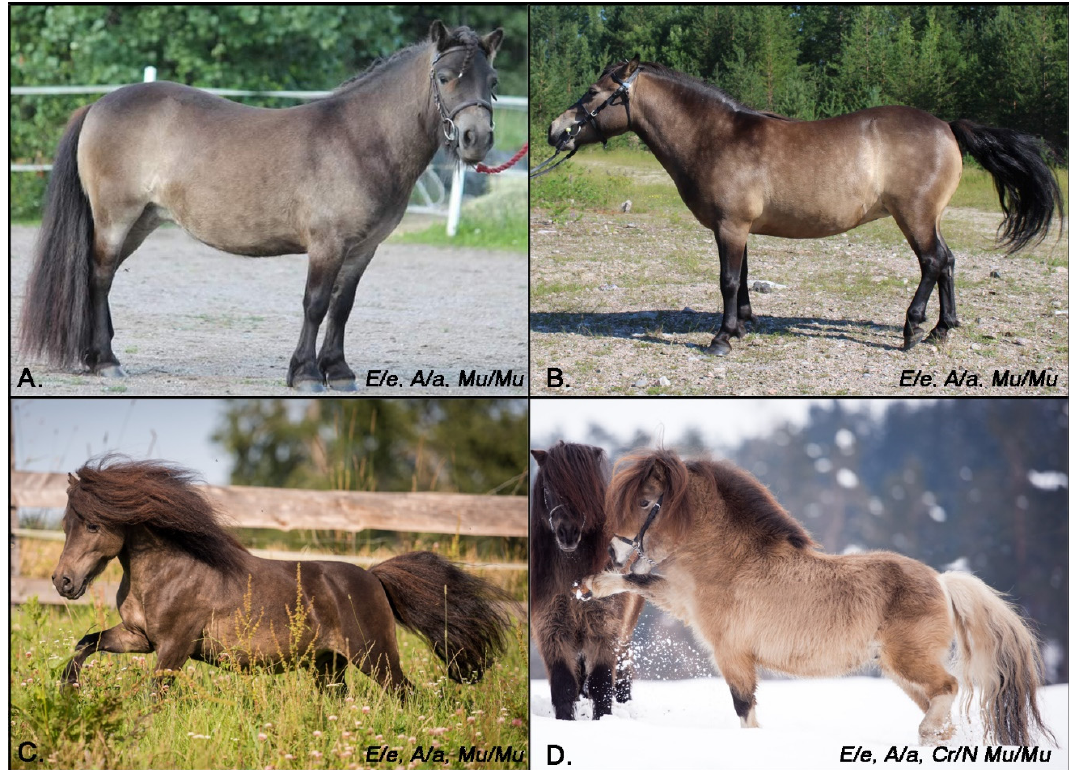
Figure 3. Bay mushroom Shetland Ponies. ( A ), ( B ), ( C ) Three bay ponies homozygous for the mushroom variant showing a coat lacking the red hue as typically seen in bay horses without the mushroom dilution. These bay mushroom ponies have normally pigmented mane and tail with countershading on the shoulders neck and head of these ponies. ( D ) Buckskin homozygous for the mushroom variant. The countershading is consistent with other “bay mushroom” ponies though the combination of mushroom and cream is likely contributing to the lighter shade in the coat of this pony as compared to the other bay mushrooms. Photo credits ( A ) Maria and Joana Tammi ( B ) Mira Ruotsalainen ( C ) and ( D ) Katrin Lach and Claudia Rahlmeier